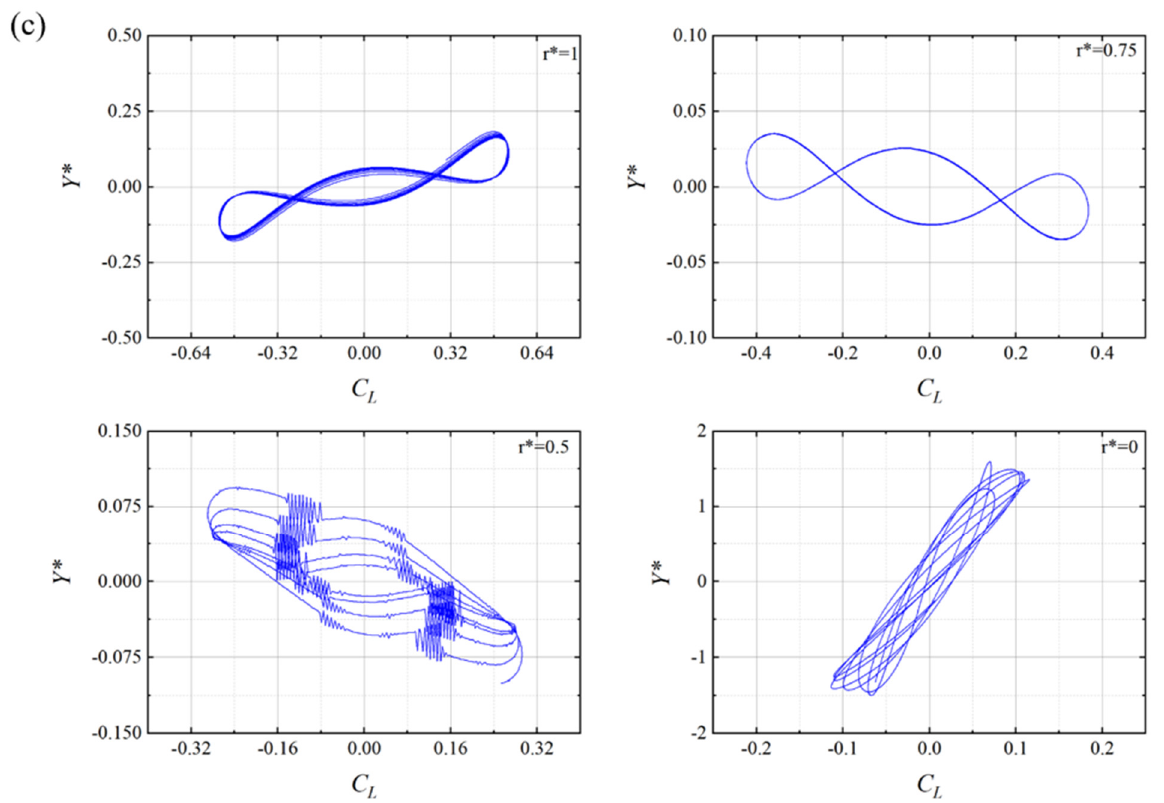
Figure 7. Effect of 𝑟 ∗ on vortex-induced vibration at Re =2 00 and 𝑈𝑟 = 4.92 . ( a ) Time histories of the lift coefficient. ( b ) Flow field of different radius corners. ( c ) Phase diagrams illustrating the displacement vs. lift coefficient.